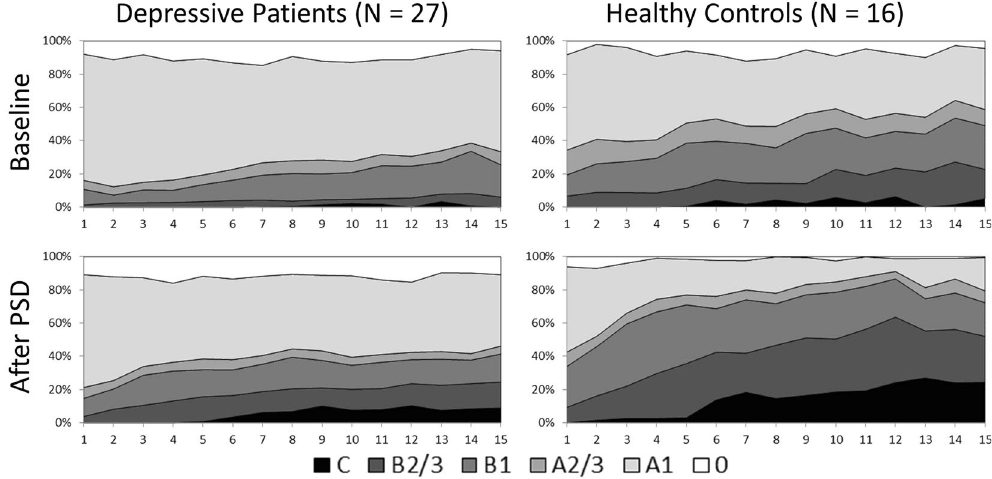
Figure 1. Time-course of EEG-vigilance stages during 15 minutes of resting EEG between patients and healthy controls on day 1 (baseline, upper row) and day 2 (after sleep deprivation (PSD), lower row).